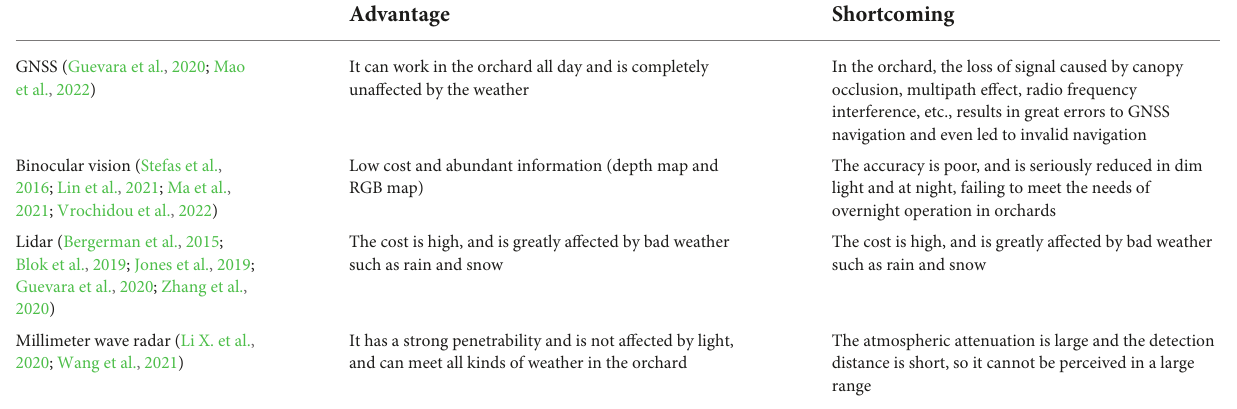
TABLE 1 Classification of driverless perception and decision system working in orchard.